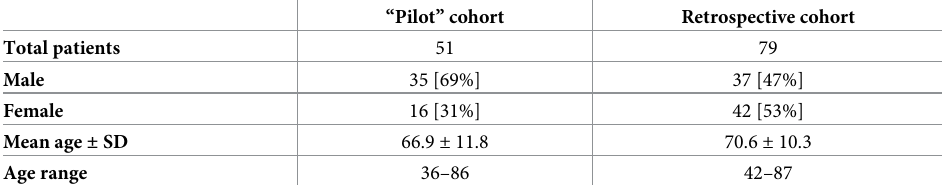
Table 1. Amyloidosis cases